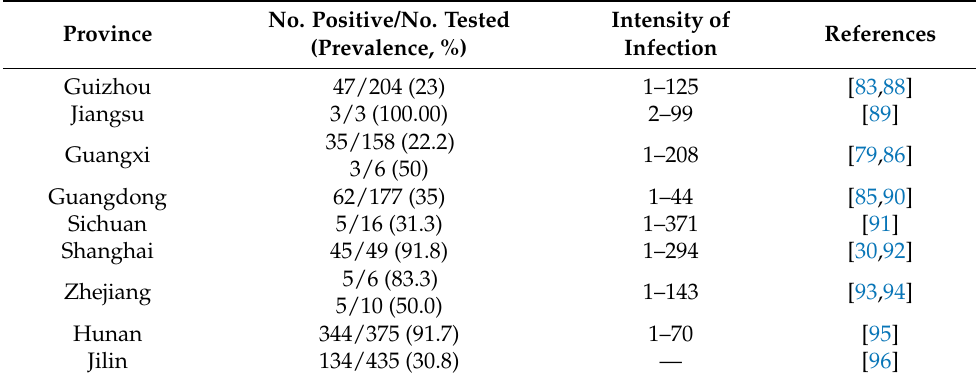
Table 2. Epidemiological investigation of snake sparganosis in China (1990–2018).